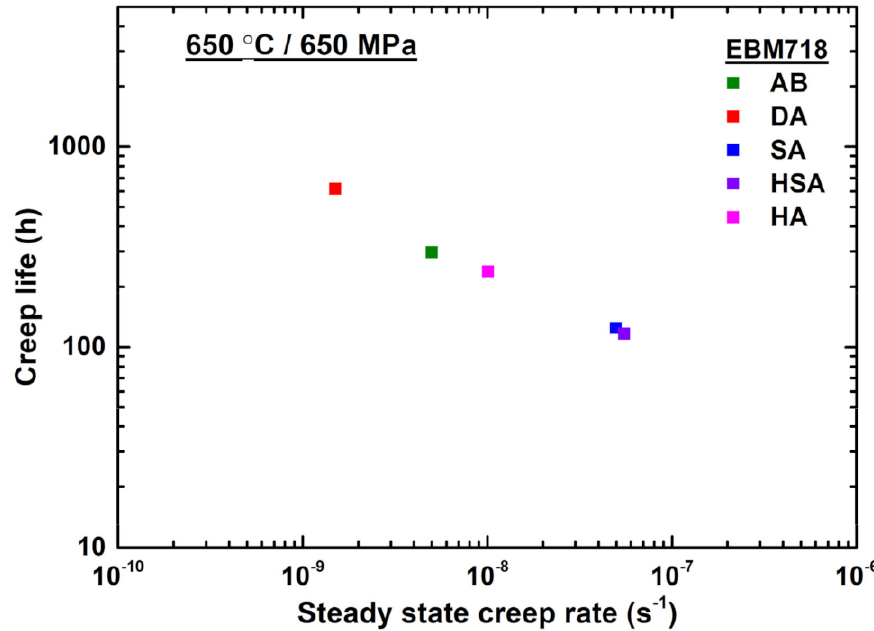
Figure 10. Relationship between creep life and steady rate creep rate for various heat treated